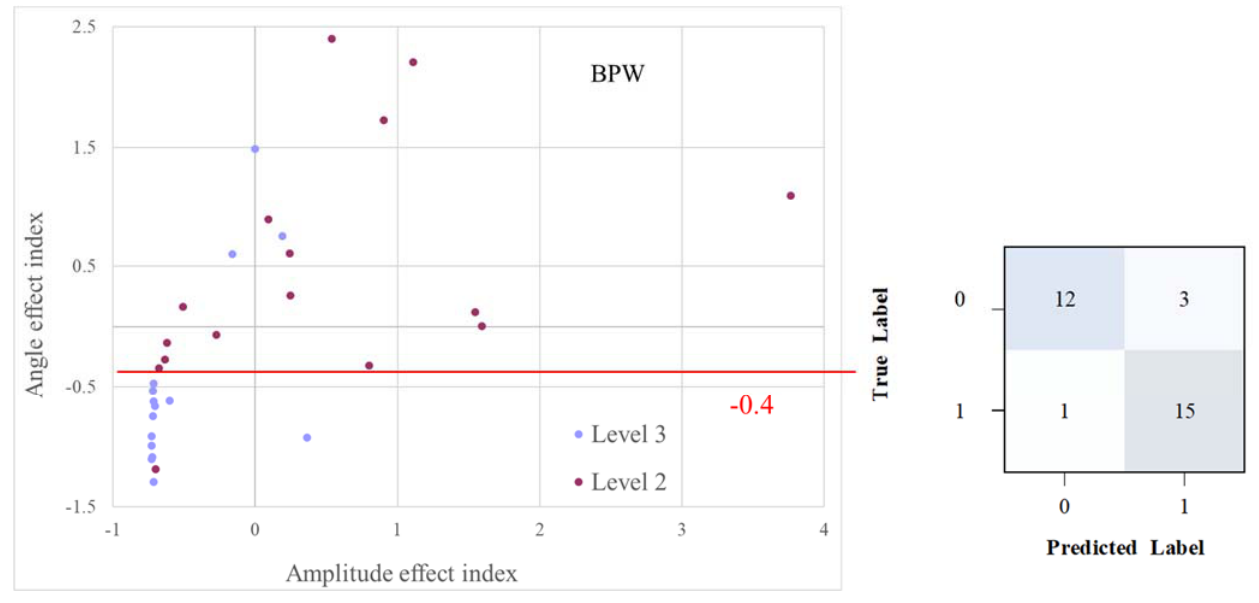
Figure 7. Using relative change distributions of pulse-effect indices to discriminate among groups. For BPW indices, choosing − 0.4 as the angle-effect threshold resulted in almost perfect discrimination (AUC = 0.878) between the Level-3 and Level-2 groups.